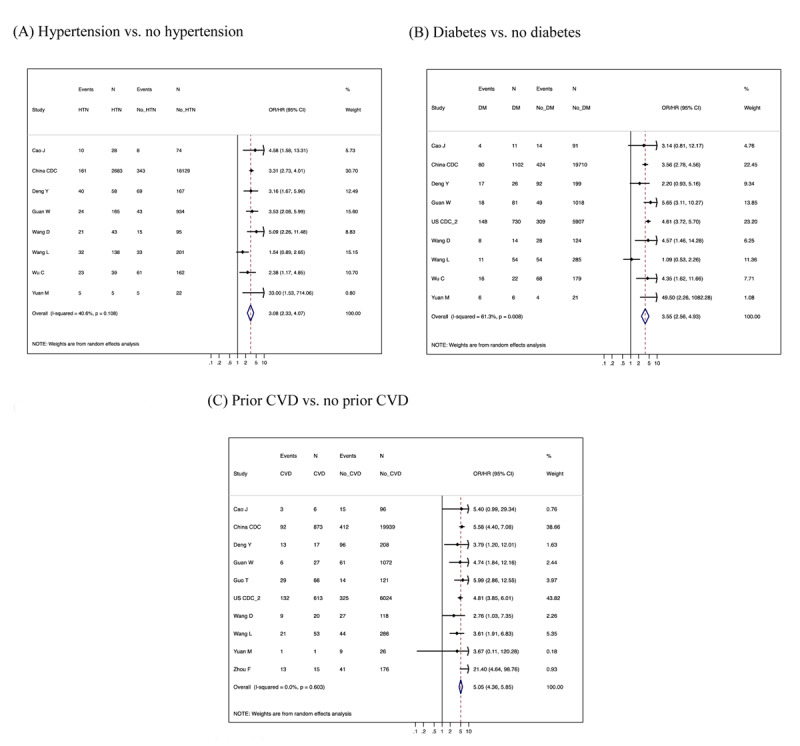
Forest plots of unadjusted relative risk estimates of severe COVID-19 according to hypertension (A), diabetes (B), and prior CVD (C) on restrictive meta-analysis.